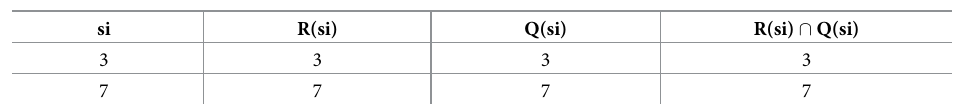
Table 7. Division of the fourth-level